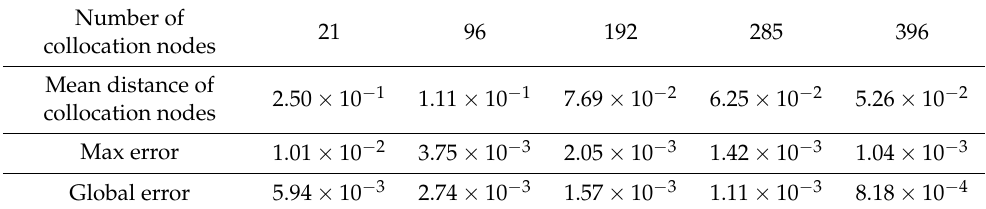
Table 1. Max and global errors of hydraulic head H with different number of collocation nodes.